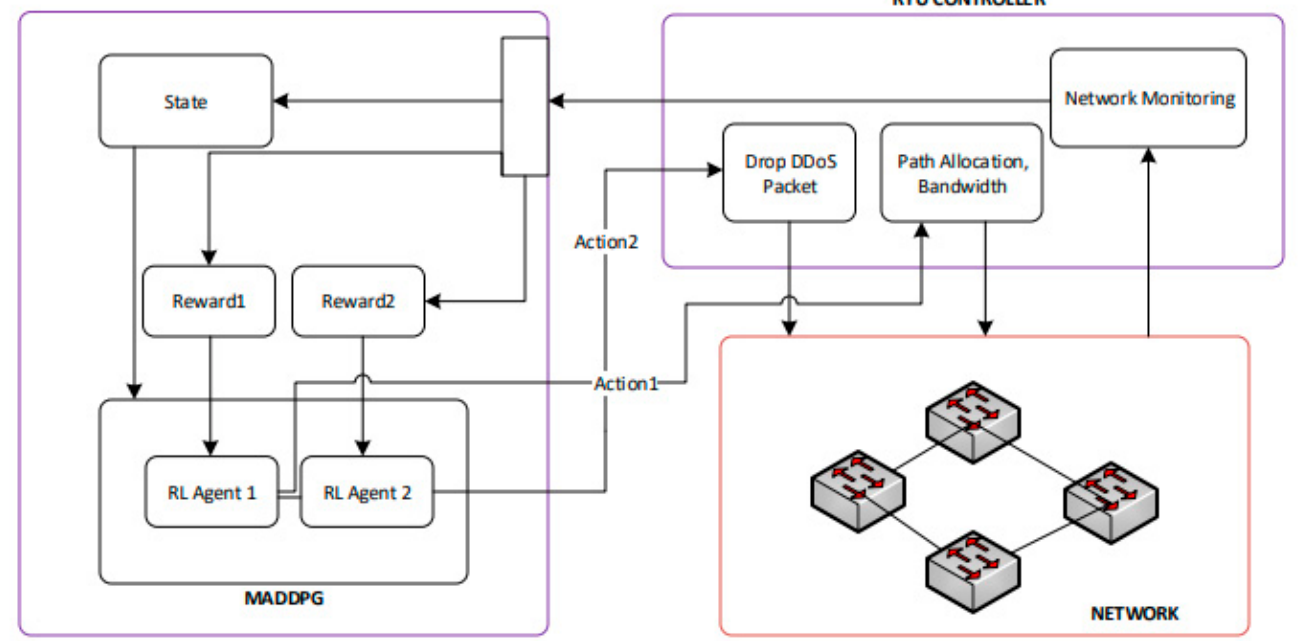
Figure 8. MARL MADDPG flow diagram.